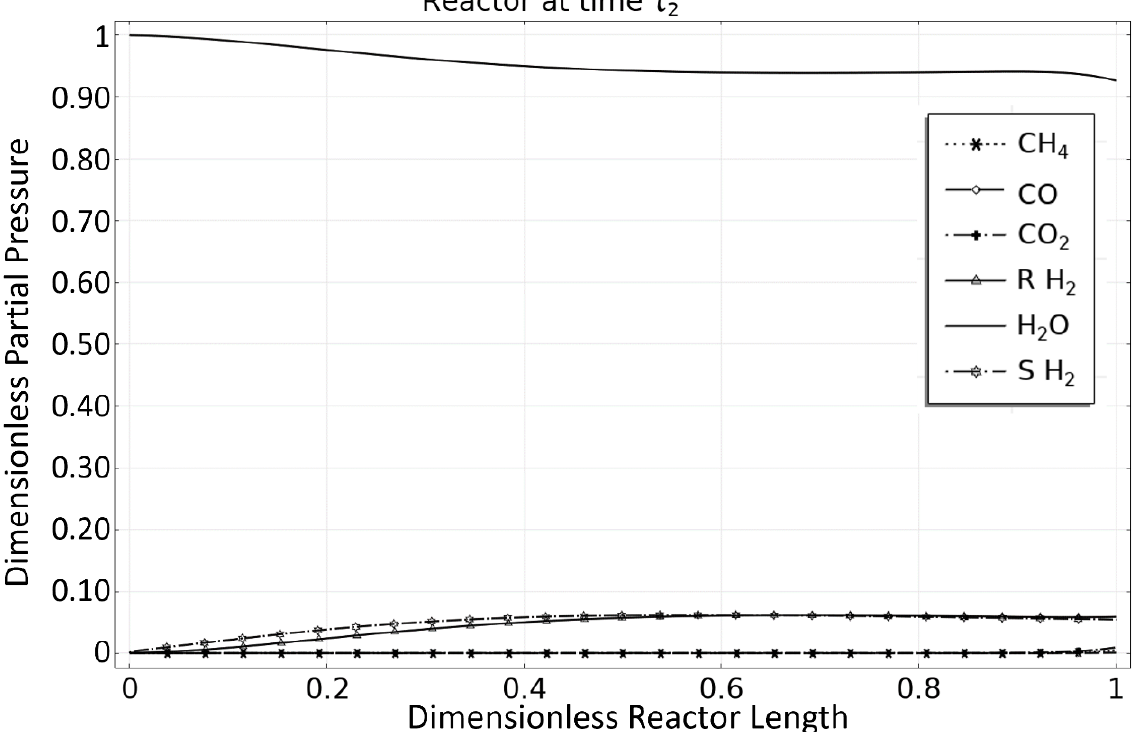
Figure 8. Species’ dimensionless partial pressure axial length profile during cycle 3 at the end of OM 2 for Da = 2, Θ = 10.